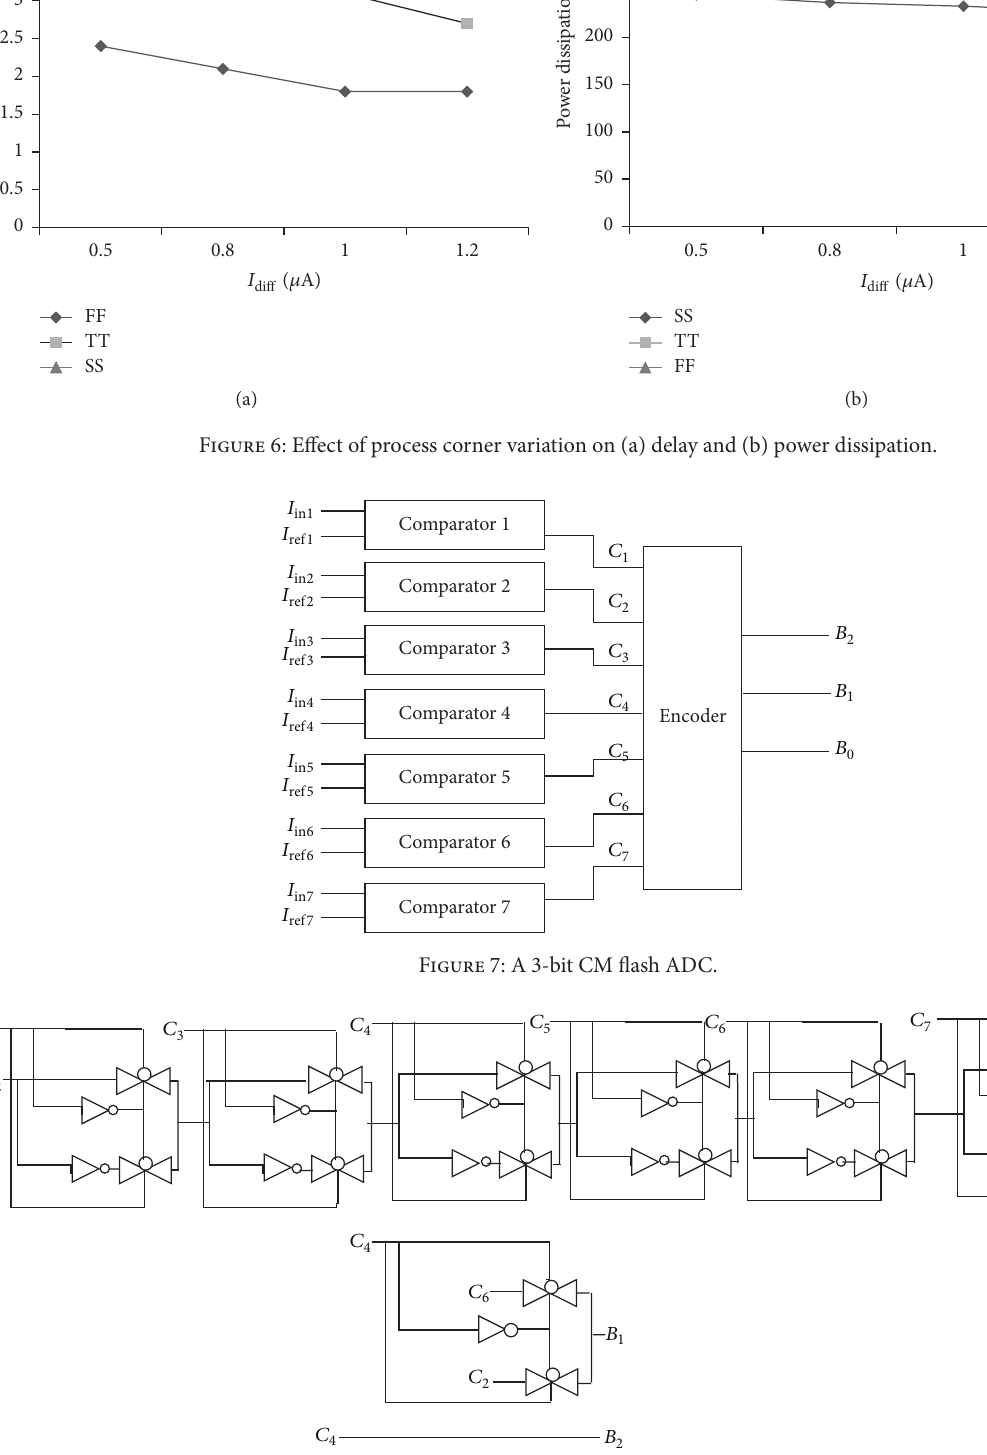
Figure 8: 7 × 3 CMOS